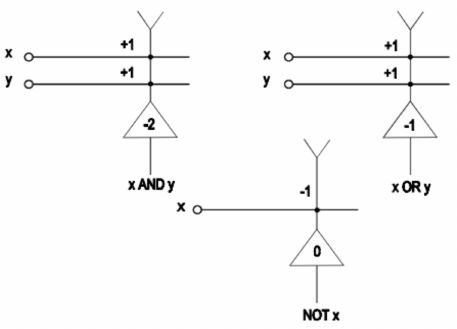
Figure 6. McCulloch-Pitts formal neurons.